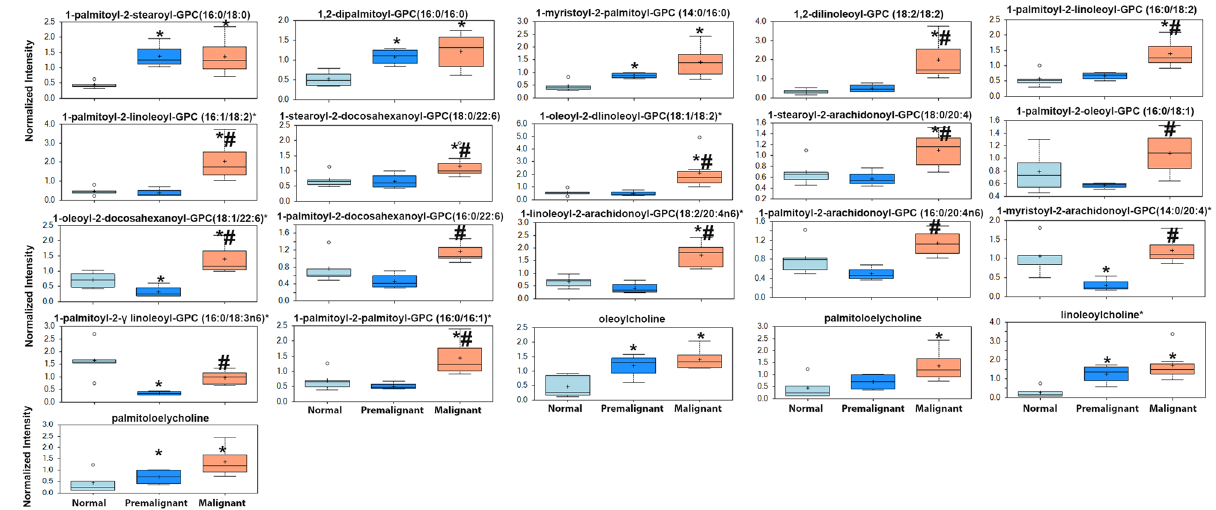
Figure 2. Upregulation of phosphatidyl choline metabolites and choline-conjugated FA. The expression levels of the indicated metabolites involved in phosphatidylcholine pathway * p < 0.05 compared to normal bladders